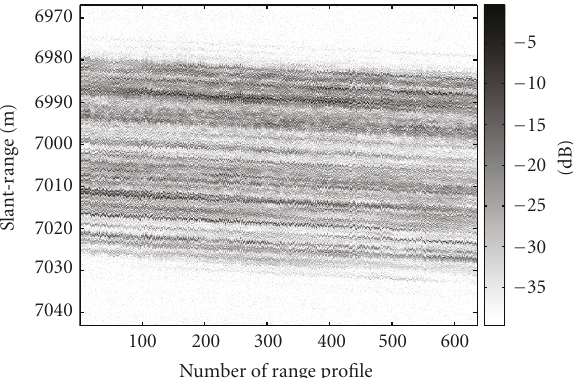
Figure 17: Range profiles of the vessel with an artificially induced vibration.